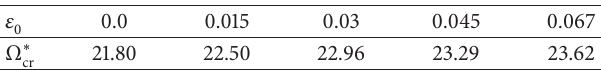
Table 6: The critical rotating speed corresponding to the different initial strains of SMA wire ( 𝑇 = 50 ∘ C, 𝑉 𝑠 = 0.36